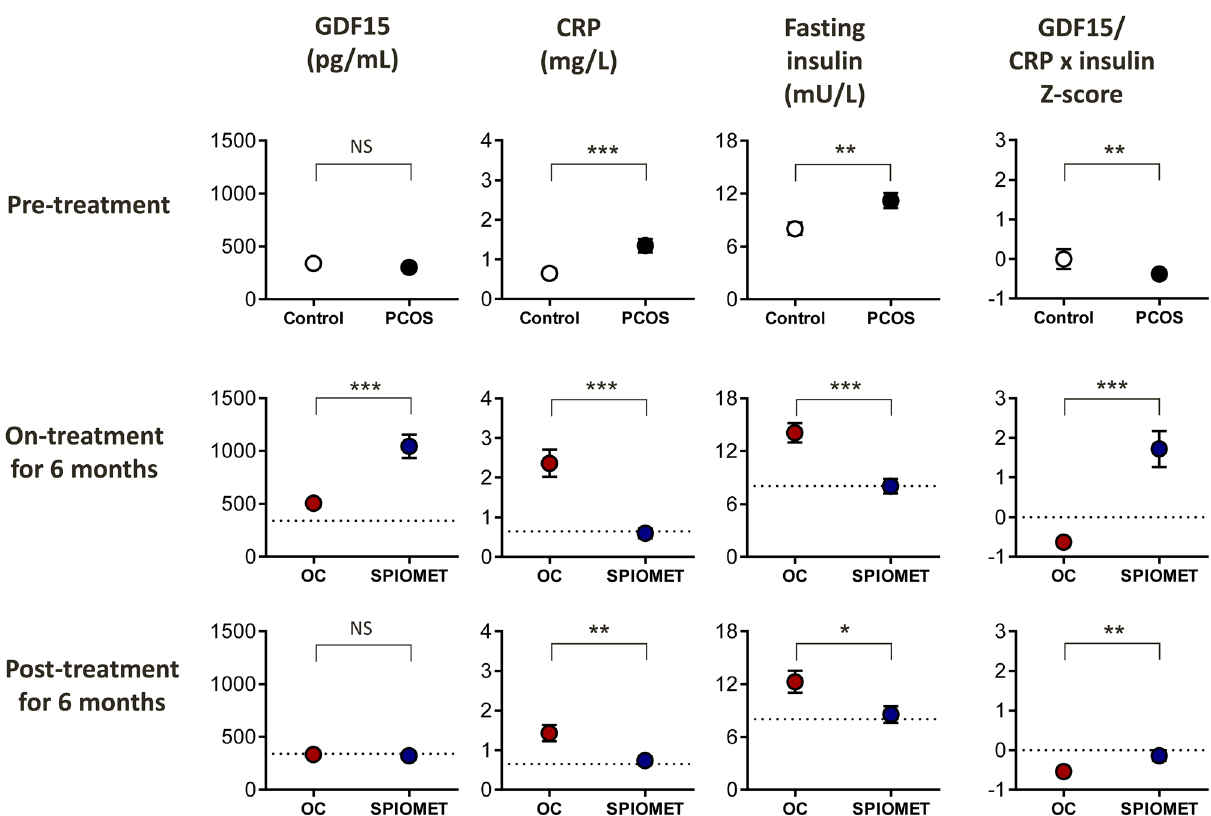
Figure 1. Circulating levels of GDF15, C-reactive protein (CRP) and fasting insulin are shown, as well as the Z-score of the ratio of GDF15 to the product of CRP and fasting insulin. Results are expressed as mean ± SEM. Upper panels show the pre-treatment results in healthy controls (N = 20) and in adolescent girls with polycystic ovary syndrome (PCOS, N = 58). Middle panels show the results in girls with PCOS, 6 months after starting a randomised treatment with either an oral contraceptive containing ethinyloestradiol plus levonorgestrel (OC; red circles N = 29) or a low-dose combination of spironolactone, pioglitazone, and metformin (SPIOMET; blue circles, N = 29) for 12 months. Lower panels show the results in girls with PCOS, 6 months after stopping OC or SPIOMET treatment. * p < 0.05, **p < 0.01, ***p < 0.001 between control and PCOS (upper panels), or between OC and SPIOMET (middle and lower